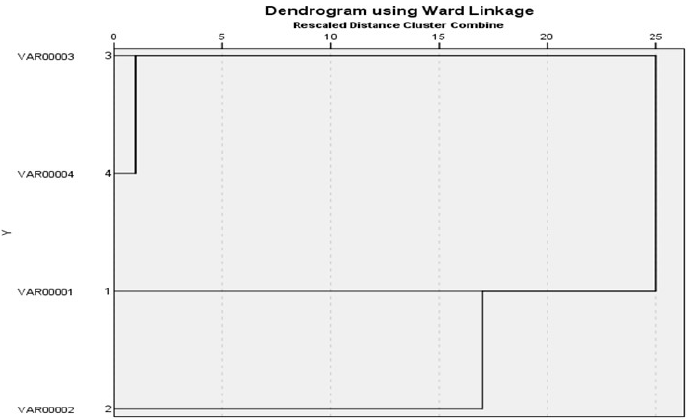
Figure 7. Dendrograms were generated by the unweighted pair group method with arithmetic average (UPGMA) and Ward’s hierarchical clustering routine. Similarity index (Jaccard/Tanimoto coefficient and the number of intersecting elements) between all samples were calculated using the online tool (https://planetcalc.com/1664/, accessed on 21 May 2022).